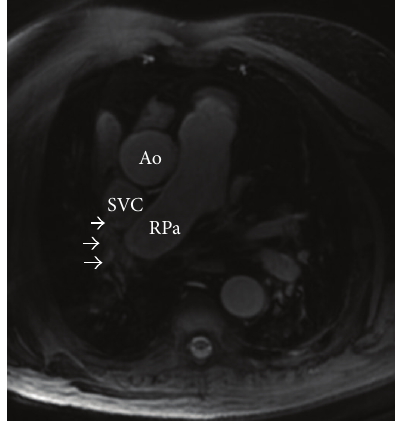
Figure 4: Axial 3-dimensional steady state free precession (SSFP) magnetic resonance image demonstrating anomalous pulmonary venous return of the right superior pulmonary vein into the superior vena cava. Right upper lobe partial anomalous pulmonary venous return (arrows). SVC: superior vena cava; RPa: right pulmonary artery; Ao: aorta.